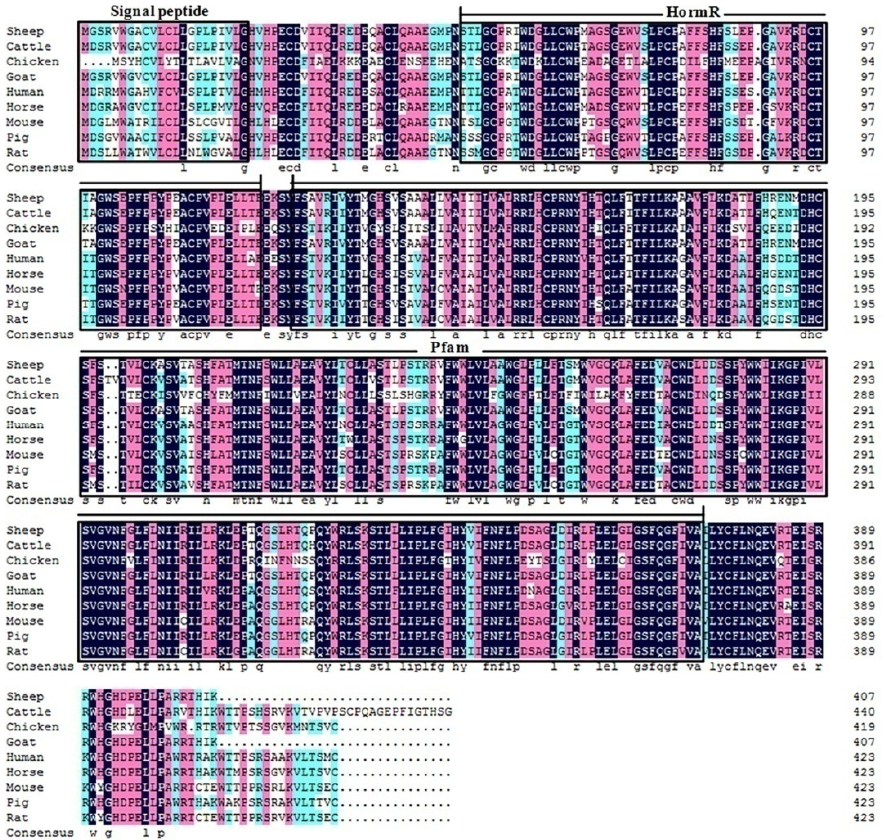
Figure 1. The conservative analysis of GHRHR protein in nine animals (Human, Homo sapiens NP_000814.2; Rat, Rattus norvegicus NP_062024.1; Cattle, Bos taurus NP_851363.1; Goat, Capra hircus XP_005679295.2; Sheep, Ovis aries NP_001009454.3; Horse, Equus caballus XP_001916581.2; Mouse, Mus musculus NP_001003685.2; Pig, Sus scrofa NP_999200.1; Chicken, Gallus gallus NP_001032923.1). Signal peptide was located at 1–22 sites; HormR (51–121) was present in hormone receptors, and involved in regulating G protein-coupled receptor activity; Pfam (126–374) participated in G protein-coupled receptor signaling pathways and regulated G protein-coupled receptor